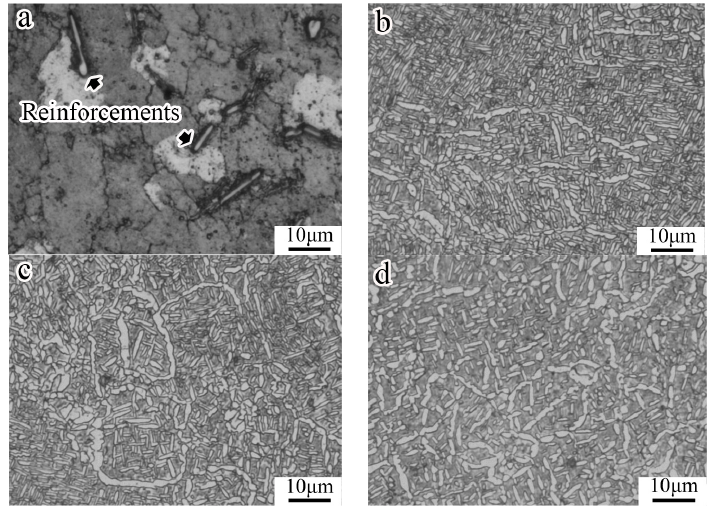
Figure 1. Optical microscope (OM) images of ( a ) alloy A after thermomechanical processing; ( b ) unmodified alloy after heat treatment; ( c ) alloy A after heat treatment; and ( d ) alloy B after heat treatment.